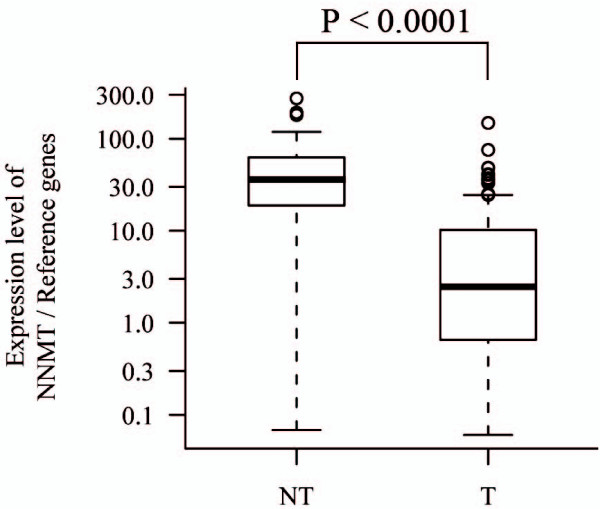
Box and whiskers plot for NNMT mRNA levels in non-cancerous liver (NT) and HCC (T) determined by real-time RT-PCR. The box is marked by the first and third quartile with the median marked by a thick line. The whiskers extend to the most extreme data point which is no more than 1.5 times the interquartile range from the box.